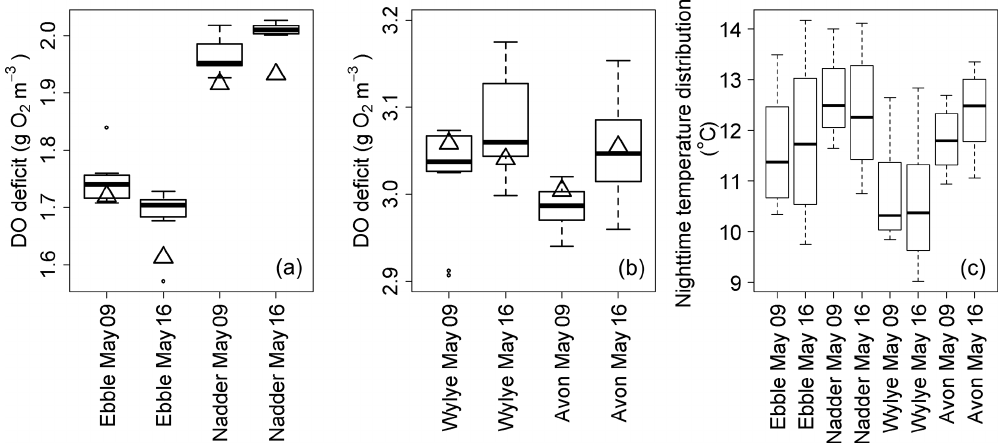
Figure 6. Box plot time series of DO deficits at points of steady-state DO for the nights of 9/10 and 16/17 May 2015 for Ebble and Nadder (a) and Wylye and Avon (b) . Values for the regression quotient are shown as triangles. Panel (c) shows corresponding distributions of nighttime